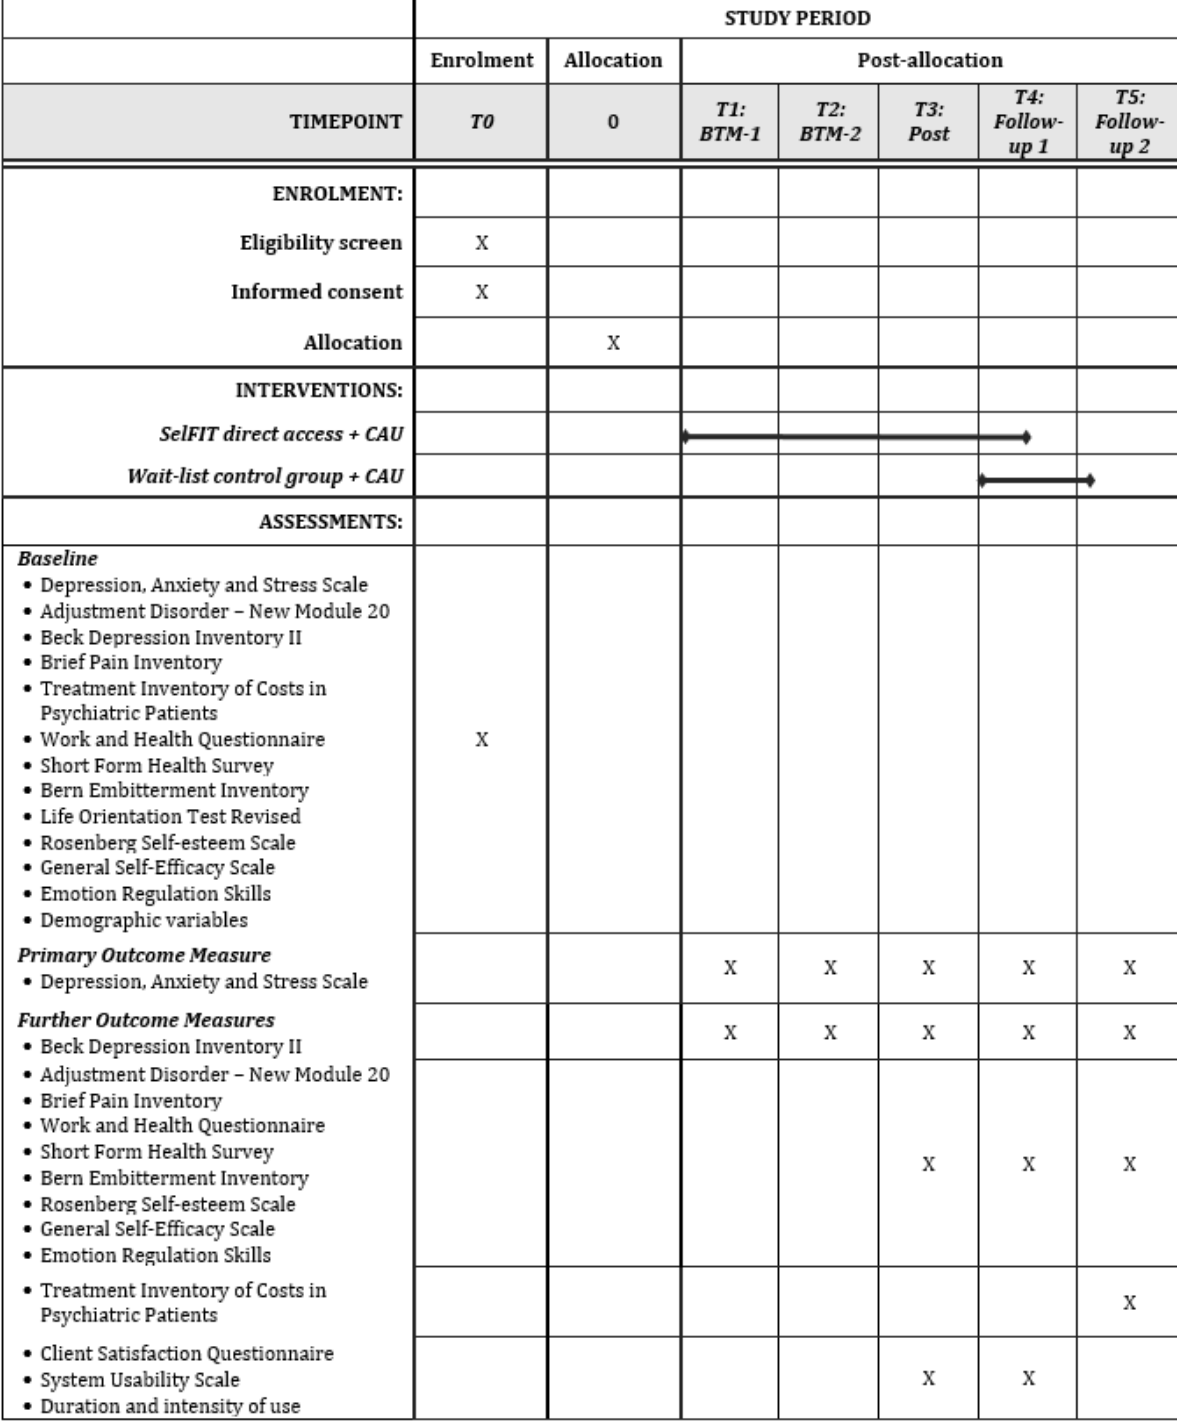
Figure 2. SPIRIT (Standard Protocol Items: Recommendations for Interventional Trials) figure to display the study’s schedule of enrolment, interventions, and assessments. BTM: between-measurement. CAU: care as